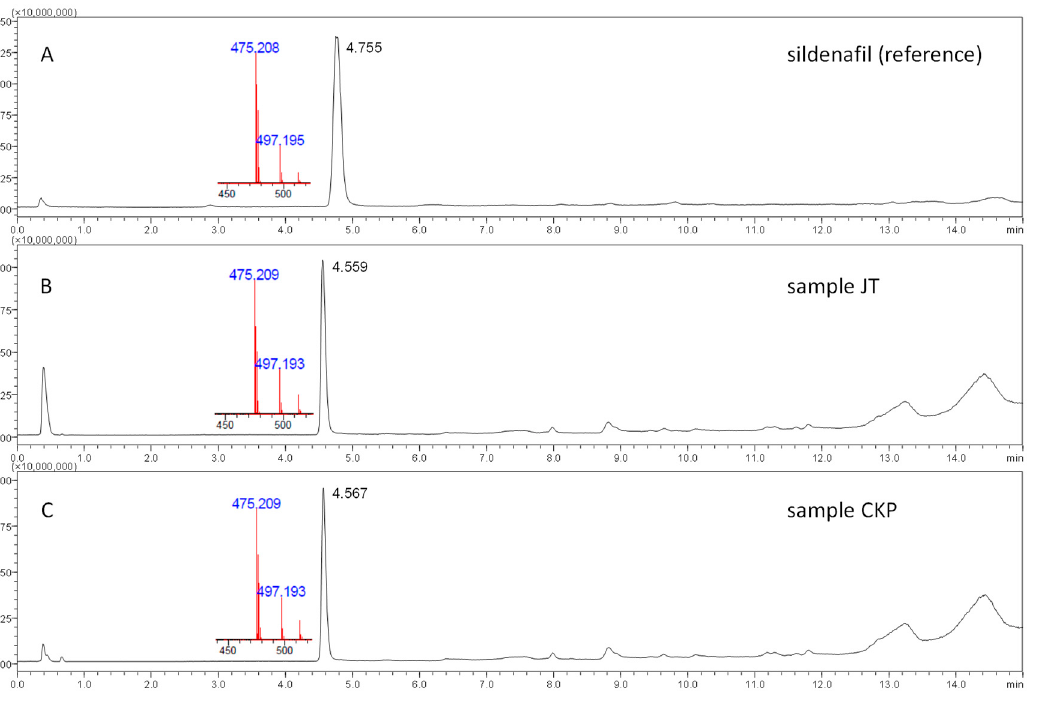
Figure 1. LCMS chromatograms of ( A ) sildenafil standard and two dietary supplement samples: JT ( B ) and CKP ( C ). Inserts included in all three panels show MS spectra collected at 4.75/4.56/4.57 min. Peak m / z = 475.208 corresponds to the [M + H] + ion for sildenafil, m / z = 497.193 and 513.167 to [M + Na] + and [M + K] + , respectively.